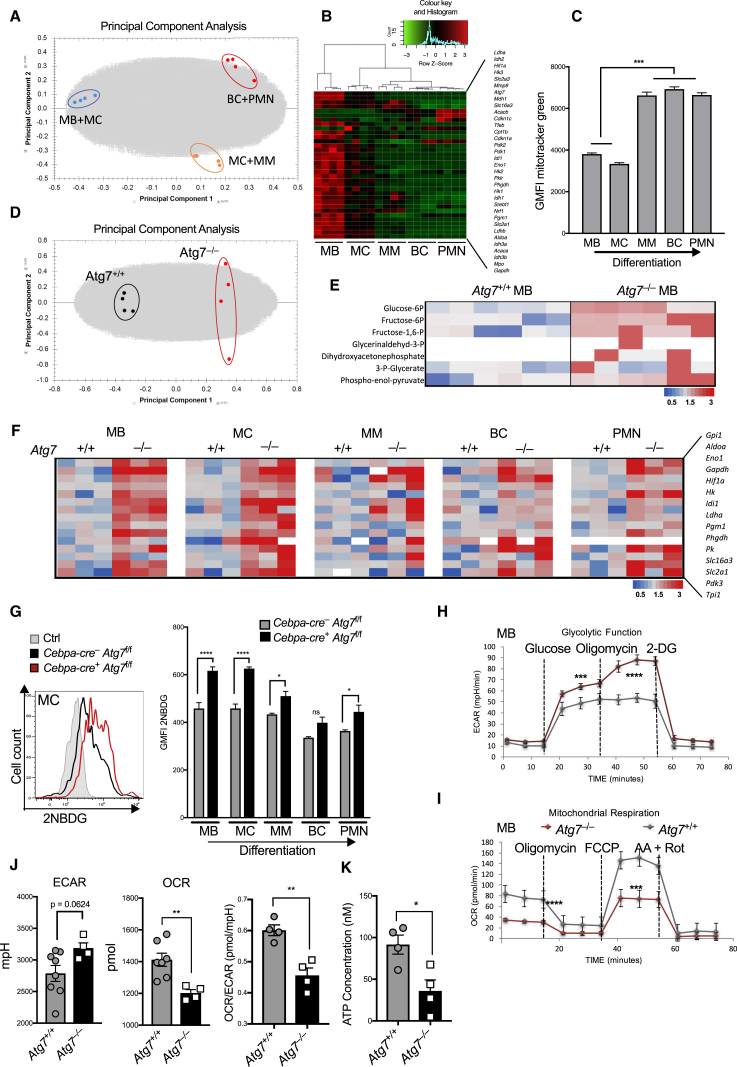
Autophagy Is Required to Maintain Metabolic Balance during Granulopoiesis(A, D, and E) Metabolites were extracted from 5 × 106 cells of the indicated genotypes and metabolomic data were acquired by ICxMS/MS. Data from one experiment with six biological replicates.(A) Principal component analysis of myeloblasts after 2 and 5 days of G-CSF-induced differentiation (100 nM), scored based on the 4,215 detected metabolites (with Hotellings T2 ellipse at 0.95).(B) Microfluidic gene expression analysis with the Fluidigm-Biomark array for the indicated metabolic genes (100 cells/population) in five neutrophil differentiation stages sorted by flow cytometry from wild-type mouse BM. Unsupervised clustering of replicates based on z-score (n = 4 mice).(C) Mitochondrial content was quantified by flow cytometry from wild-type mouse BM as mitotracker green fluorescence intensity in indicated neutrophil precursor populations. Data are shown as mean ± SEM (n = 3 mice). ∗∗∗p < 0.001, tested by one-way ANOVA.(D) Principal component analysis of Atg7+/+ myeloblasts and independent CRISPR Atg7–/– clones, scored based on the 4,215 detected metabolites with %CV < 30 on day 2 of G-CSF-induced differentiation.(E) Glycolysis metabolite abundance for control and CRISPR Atg7–/– clones at the myeloblast stage cultured in IL-3. Heatmap shown as fold change normalized to wild-type abundance. Data represent six biological replicates per group from two independent clones. Seven of the ten glycolytic intermediates were detectable by mass spectrometry and are presented here.(F) Gene expression profiling of the glycolytic pathway was done using the Fluidigm Biomark 48 × 48 dynamic array on 100 purified precursor cells of each of the indicated differentiation stages purified by flow cytometry from Atg7–/– and control Atg7+/+ BM. Data from three separate mice per genotype. Heatmaps are shown as fold change relative to Actin and normalized to Atg7+/+. All 15 glycolytic genes, except isoforms, were selected from the same gene panel as used in Figure 4B. Representative of three experiments.(G) Uptake of fluorescent glucose (2NBDG) during control and Cebpa-cre+ × Atg7f/f neutrophil differentiation. Representative histogram (left) shows myelocyte (MC) population. Quantification (right) as geometric MFI ± SEM (n = 3 mice/group). Data from three individual experiments. ∗p < 0.05, ∗∗∗∗p < 0.0001, tested by two-way ANOVA.(H and I) Oxygen consumption rate (OCR) (H) and extracellular acidification rate (ECAR) (I) was measured under basal conditions and in response to indicated drugs. Data represent mean of four biological replicates from two independent CRISPR Atg7–/– clones and Atg7+/+ controls at myeloblast stage cultured in IL-3.(J) Glycolysis and OXPHOS rates measured over 80 min as extracellular acidification (ECAR) and oxygen consumption (OCR), respectively, from Atg7–/– and control Atg7+/+ freshly isolated Ly6G+ BM neutrophils. The ratio of OCR/ECAR was measured every 20 min ± SEM (n = 2 mice/group). Data representative of two experiments.(K) Cellular ATP was measured with a luciferase-assay from 1 × 106 freshly isolated Ly6G+ BM neutrophils from control and Atg7–/– mice (Cebpa-cre+ × Atg7f/f, n = 4 mice/group) and concentrations determined based on a standard curve.See also Figure S4.